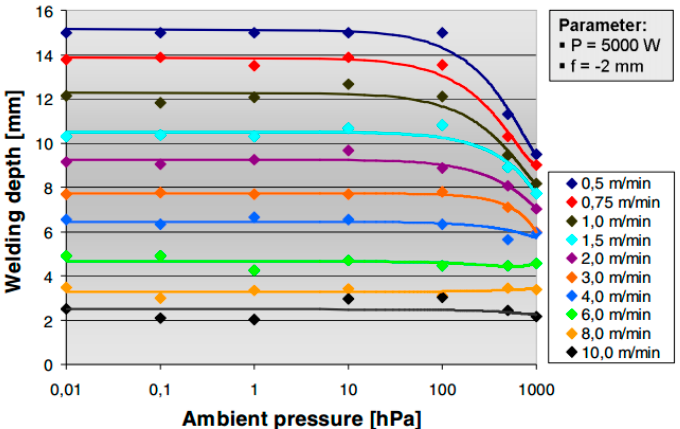
Figure 5. Effect of ambient pressure on penetration depth at various welding speed ICALEO ® 2011 Proceedings. Reproduced with permission from [33], Laser Institute of America, 2011.